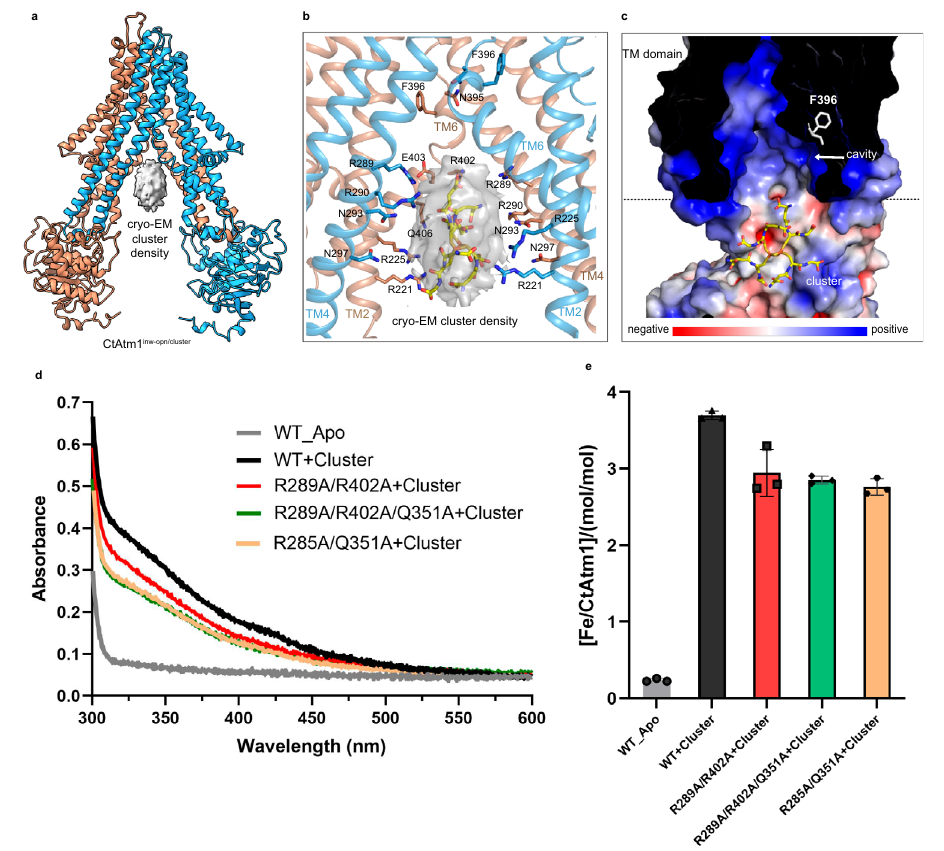
Fig. 2 | The [2Fe-2S] cluster bound inward-open structure. a The cluster bound inward-open structure, CtAtm1 inw-opn/cluster , with the cryo-EM density of the cluster (gray),andtheproteincoloredasinFig.1d. b Close-viewinthesameorientationas inpanel b of theclusterbindingwiththedockingmodelshowninyellow.Residues within 8Å of the bound cluster are shown as sticks. c The surface charge of the cavityandtheassociatedclusterbindingregioninthetransmembranedomain,cut